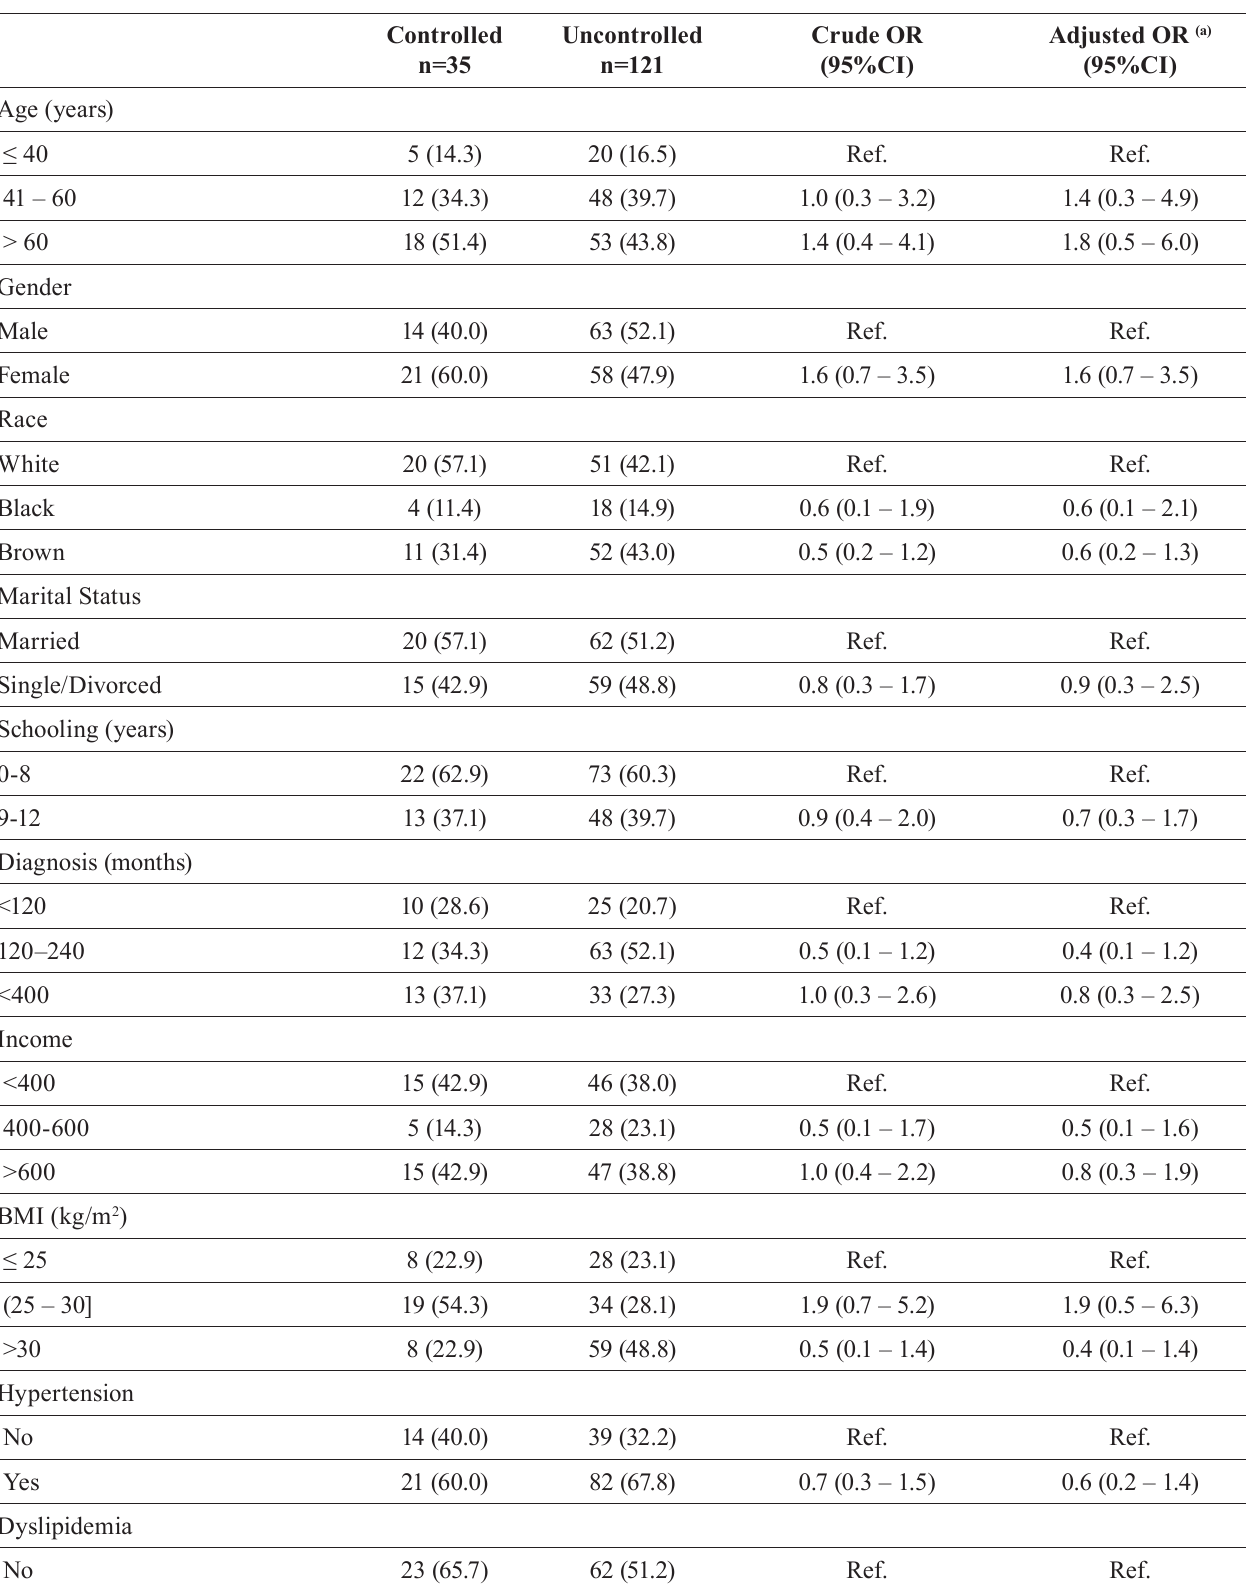
TABLE II - Logistic regression of the HB1Ac variable with the